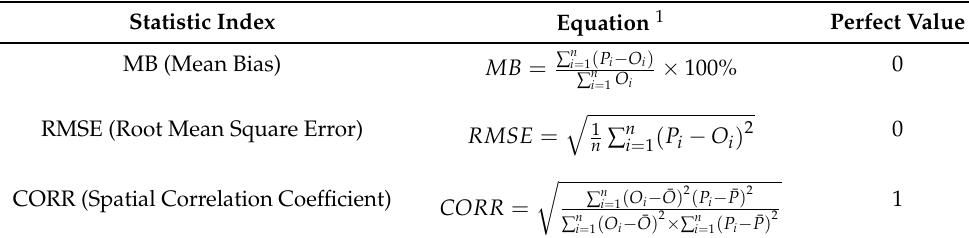
Table 2. Equations and the best values of three statistical